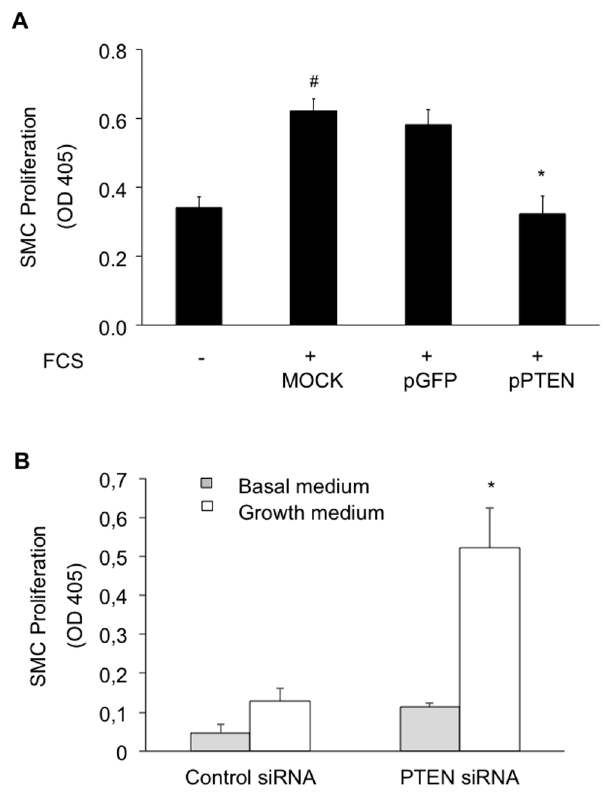
Figure 5. PTEN overexpression prevents serum-induced Akt phosphorylation after 15 min (A) and 30 min (B) serum induction using 10% FCS as determined by western blotting using an anti-pAkt-antibody. An antibody against total Akt was used as control. The potent PI3-K-inhibitor Ly294002 (50 nM) was supplemented to the medium for not-transfected cells. HcASMC were